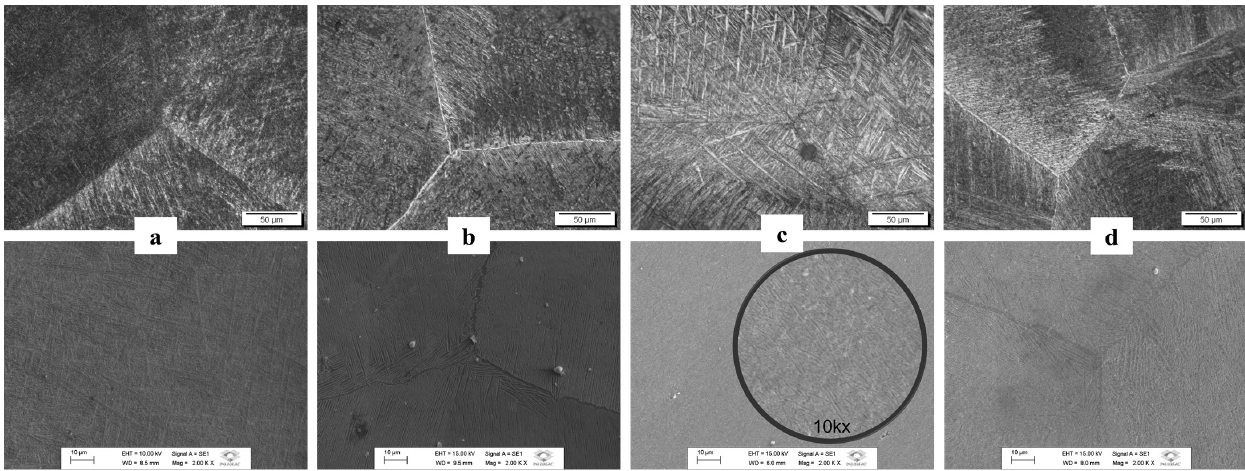
Figure 3. Optical micrographs ( above ) and SEM micrographs ( below ) in as-cast ( a ), homogenized ( b ), hot rolled ( c ), and annealed ( d ) conditions, for Ti-5Mo samples.